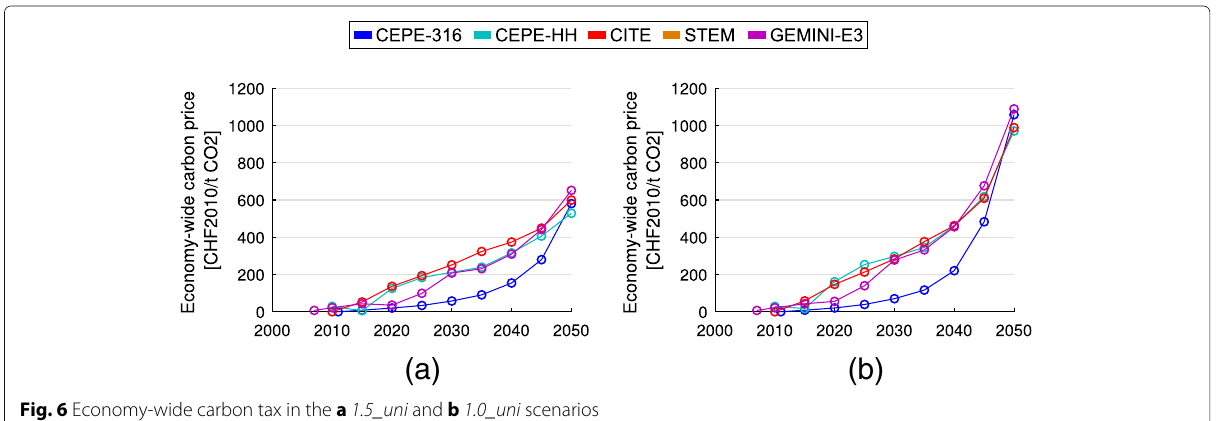
Fig. 6 Economy-wide carbon tax in the a 1.5_uni and b 1.0_uni scenarios